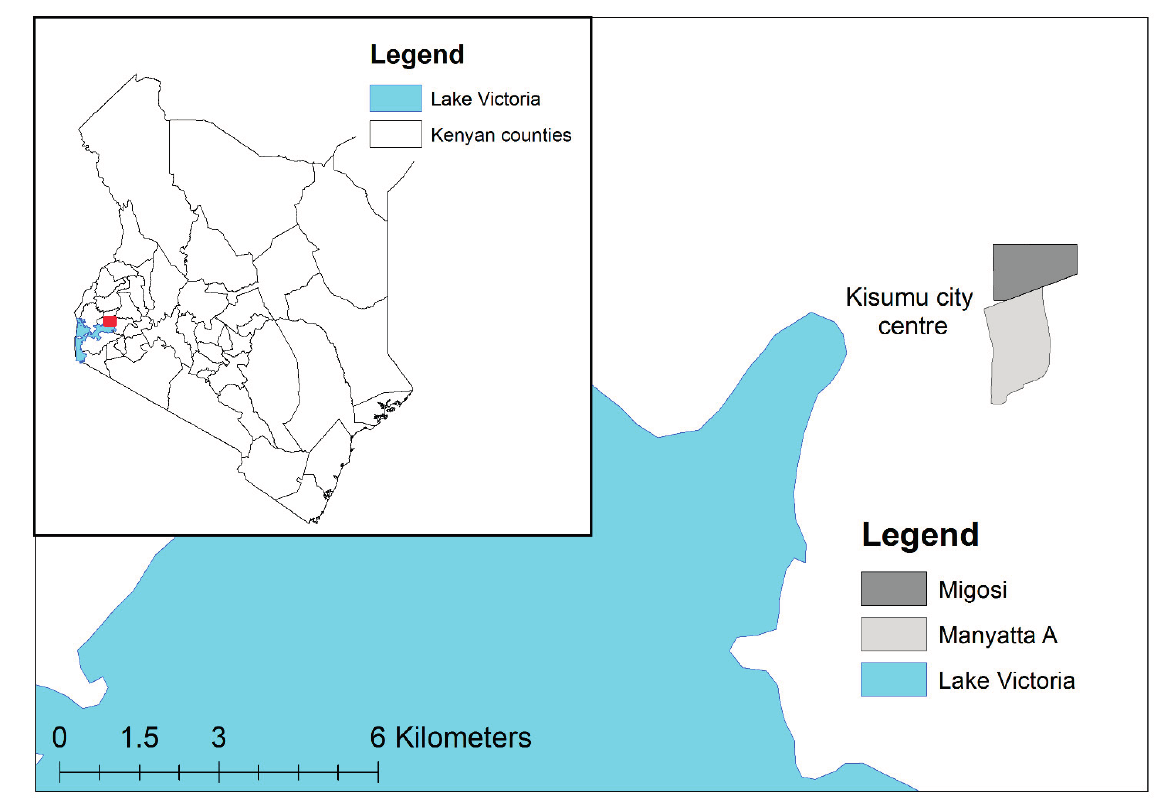
Figure 1. Location of Manyatta A and Migosi in Kisumu,